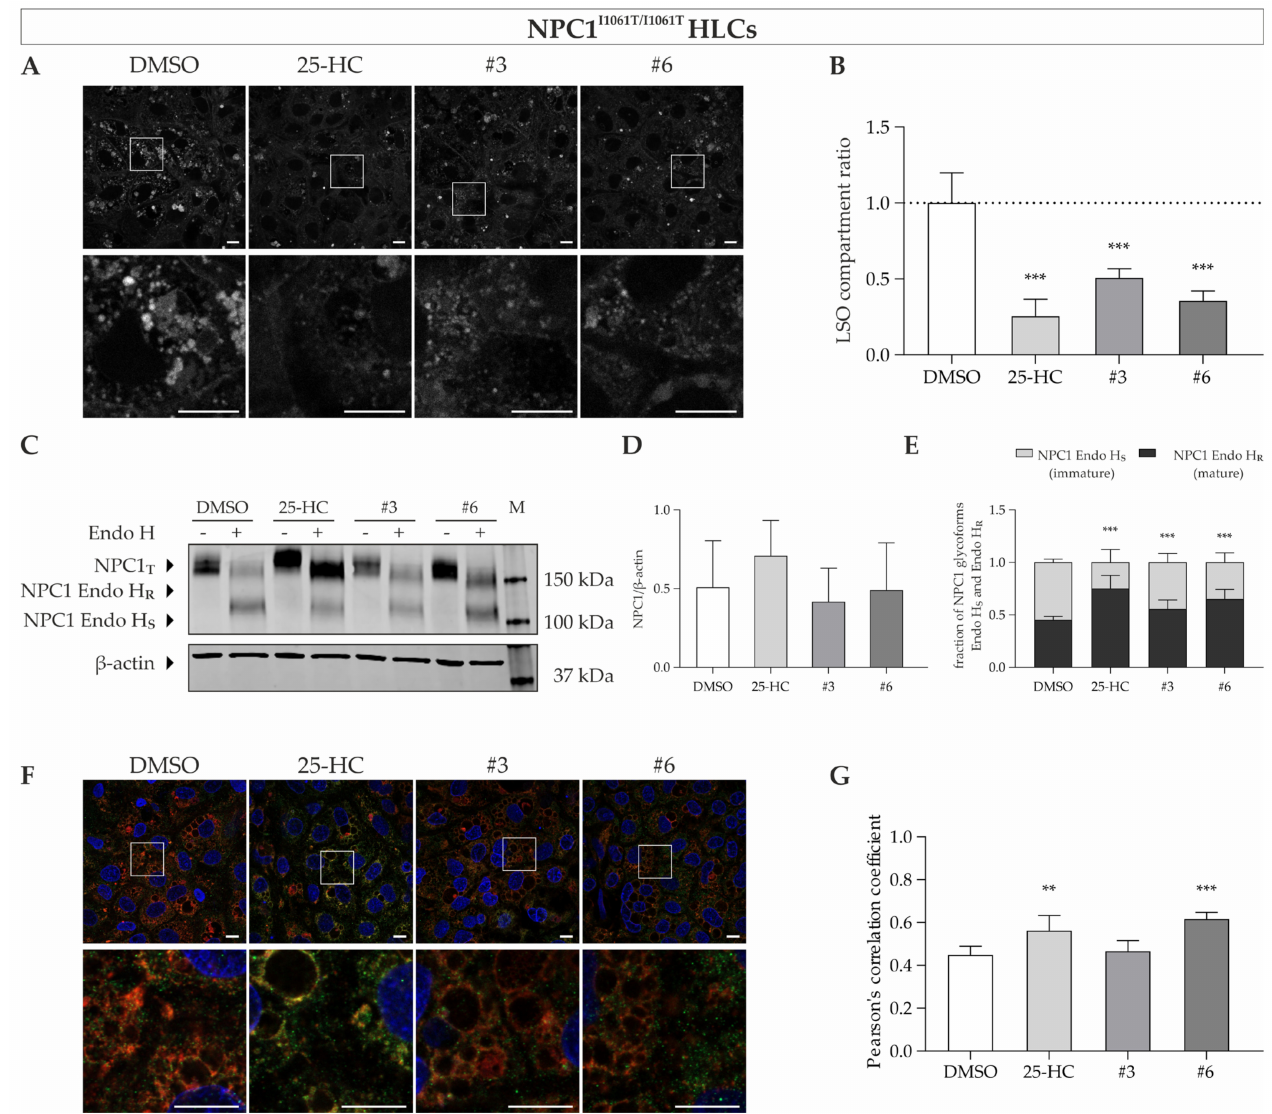
Figure 9. Treatment of NPC1 I1061T/I1061T HLCs with potential pharmacological chaperones. ( A , B ) Filipin staining and its quantitative analysis by means of LSO compartment ratio revealed a significant decrease in the HLCs cholesterol content upon treatment with the substances. N = 5. ( C ) Western blot analysis was performed to determine the effect of the substances on the total NPC1 protein levels and maturation of NPC1 protein as represented by Endo H-resistance. ( D ) While total NPC1 protein expression did not significantly change ( N = 6), ( E ) mutant NPC1 I1061T protein in HLCs has been shown to fold more properly through the action of 25-HC, quinestrol, or abiraterone acetate as shown by increased levels of mature NPC1 protein (Endo H R ). The Endo H-resistant and Endo H-sensitive glycoforms of NPC1 protein are indicated as a fraction of total NPC1 (Endo H R + Endo H S ). N = 4. ( F , G ) Immunofluorescence staining of NPC1 (green) and LAMP2 (red) in HLCs and its assessment by means of colocalization analysis demonstrates an increased lysosomal NPC1 protein content in 25-HC or abiraterone acetate treated HLCs. DAPI was used to counterstain nuclei (blue). N = 6. Scale bar = 10 µ m. ** = p < 0.01, *** = p < 0.001 by one-way ANOVA, followed by the Dunnett’s post hoc test compared to DMSO vehicle control. HLCs = hepatocyte-like cells; NPC1 T = total NPC1 protein; Endo H = Endoglycosidase H; Endo H R = Endo H-resistant; Endo H S = Endo H-sensitive; M = size